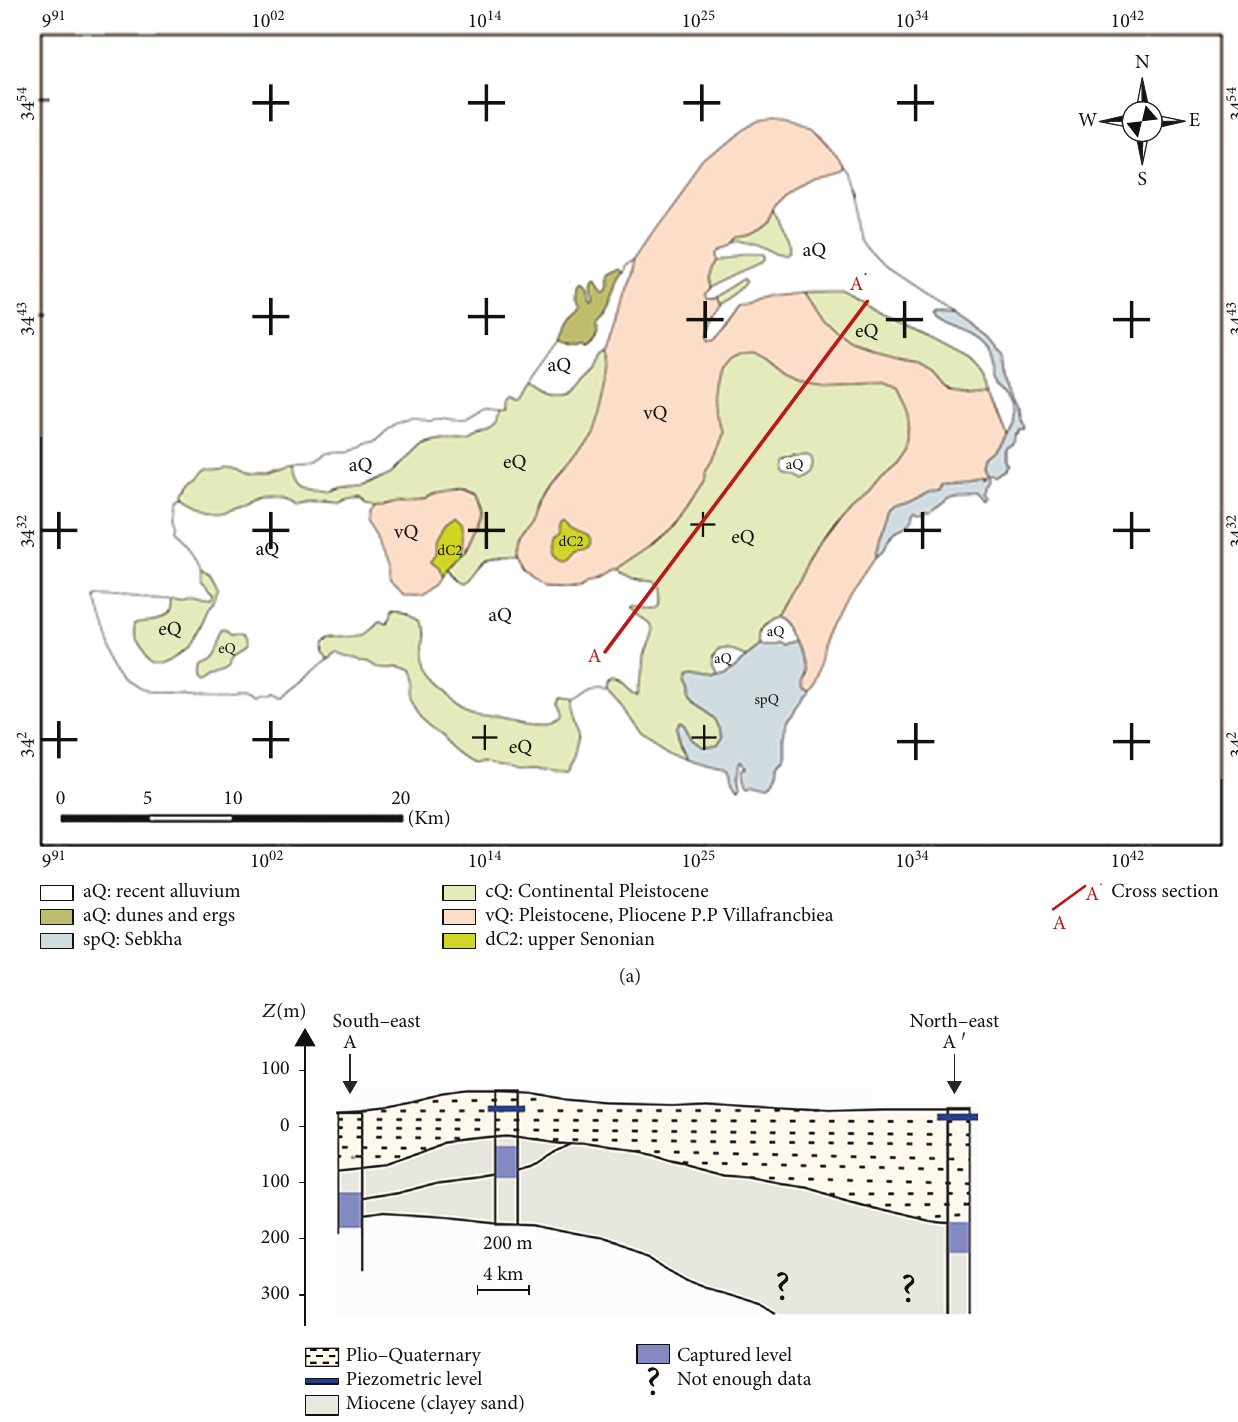
Figure 2: Geologic map of the Skhira region (a) ([42], modi fi ed) and schematic cross section along A-A ′ (b) ([14], modi fi